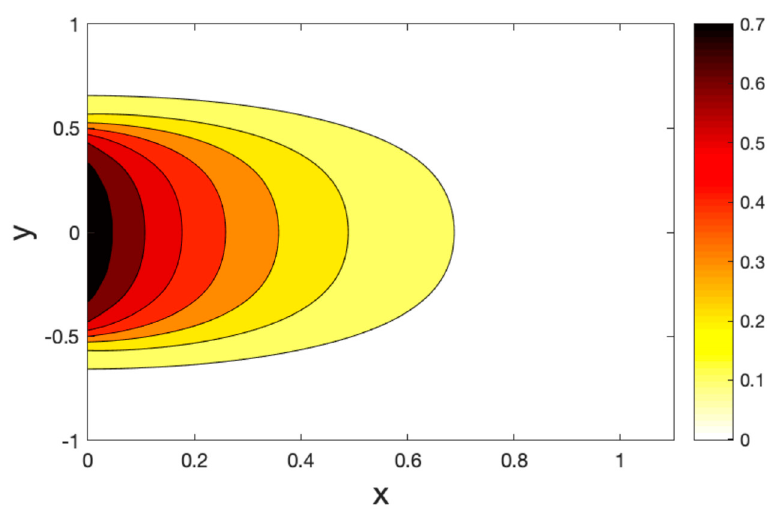
Figure 13. Contour plots of the temperature variations under the GL model.